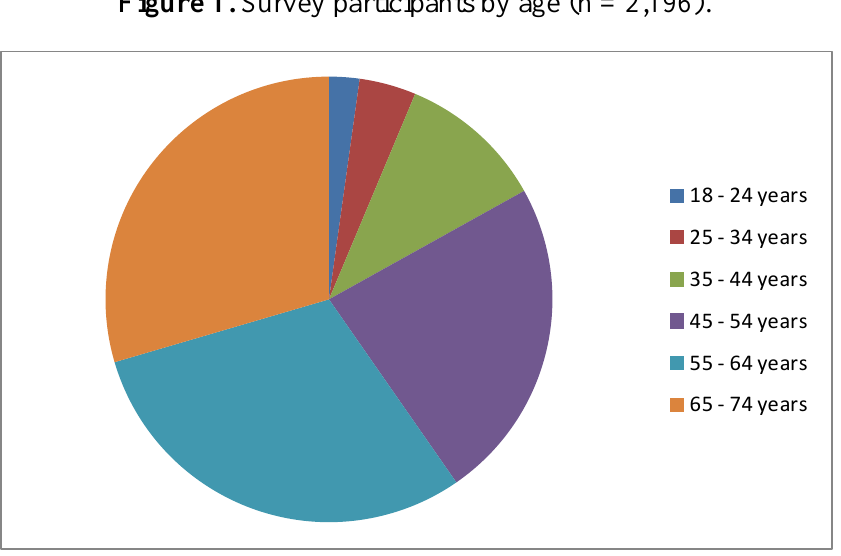
Figure 1. Survey participants by age (n =